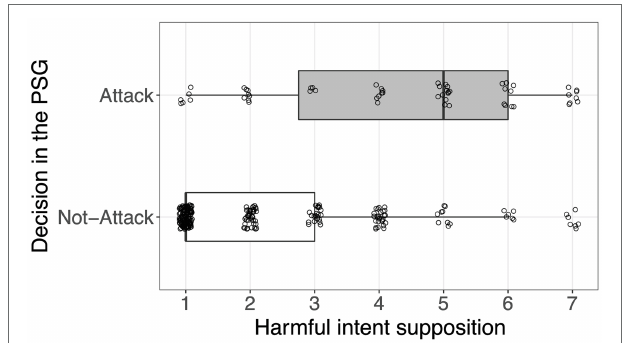
FIGURE 2 | Distributions of supposition concerning the opponent’s harmful intent by decisions made in the PSG. Each point represents each participant. Boxplots indicate the distributions of the paranoia score. The box, the thick line in each box, and the whisker represent the IQR, the median, and the distances 1.5 × IQR, respectively. Random vertical jitter was added to each point for ease of visibility.